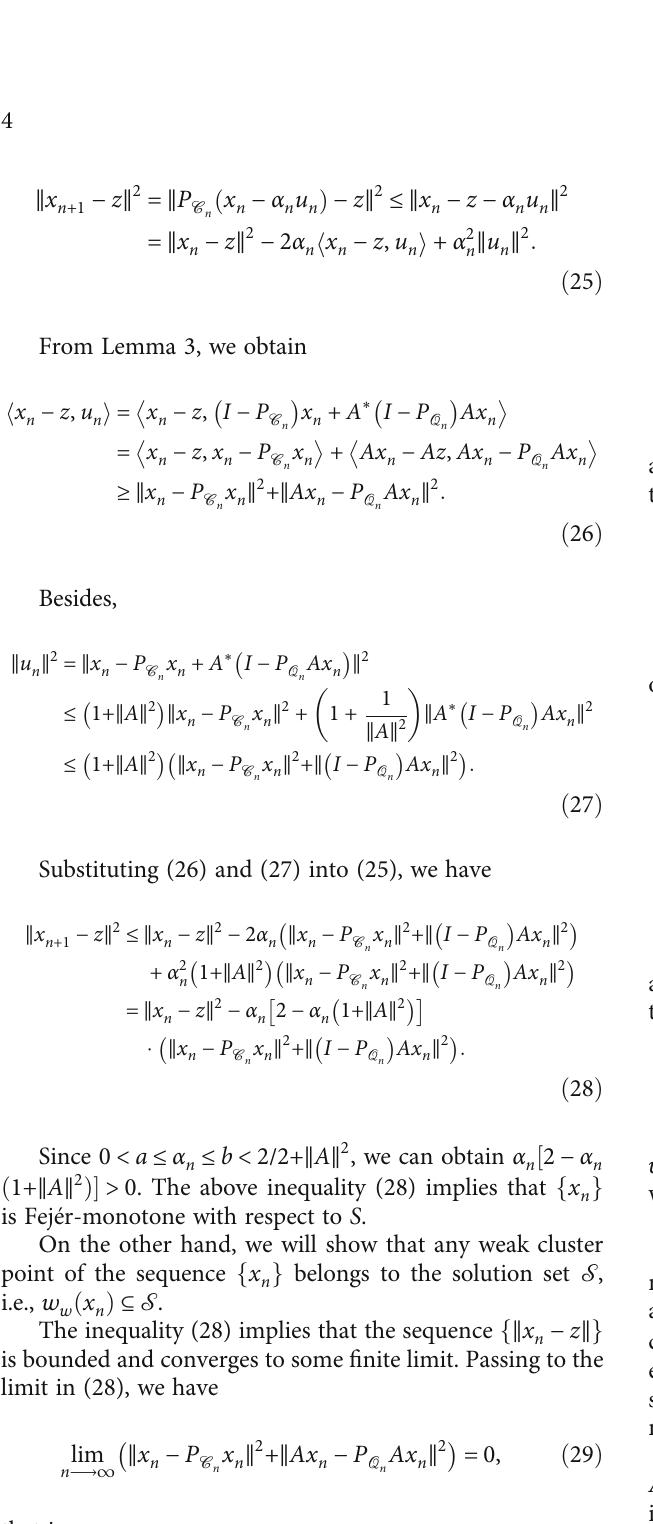
Algorithm 2. Let x be arbitrary, and generate f x n g accord- 0 ing to the following iterative